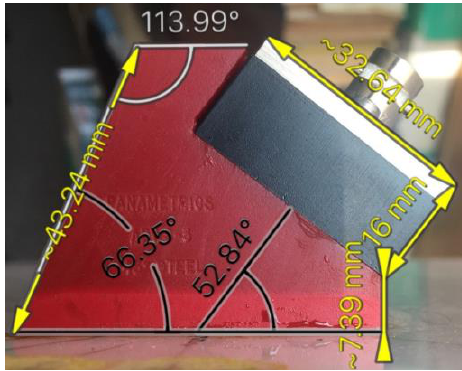
Figure 1. Photograph of the Olympus angle beam wedge transducer used and its dimensions.